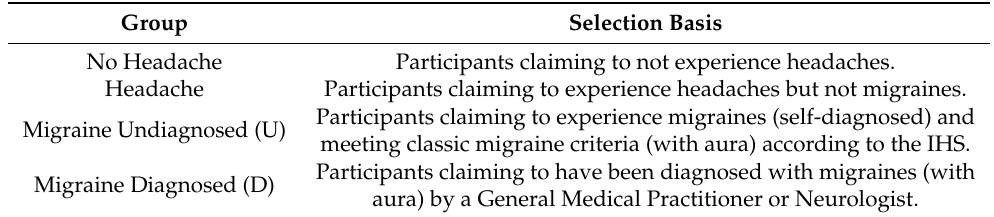
Table 1. Four Groups based on Self-report Migraine and Headache Data. Group Selection Basis No Headache Participants claiming to not experience headaches. Headache Participants claiming to experience headaches but not migraines. Participants claiming to experience migraines (self-diagnosed) and Migraine Undiagnosed (U) meeting classic migraine criteria (with aura) according to the IHS. Participants claiming to have been diagnosed with migraines (with Migraine Diagnosed (D) aura) by a General Medical Practitioner or